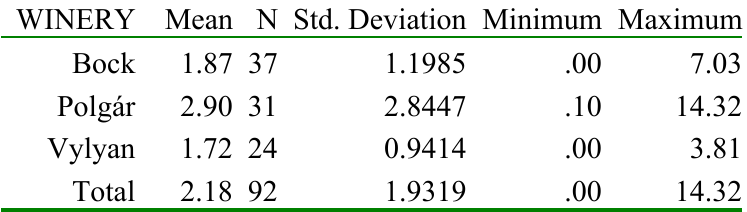
Table 2. Trans-resveratrol [mg/L] in Hungarian red wines from the “Villány”